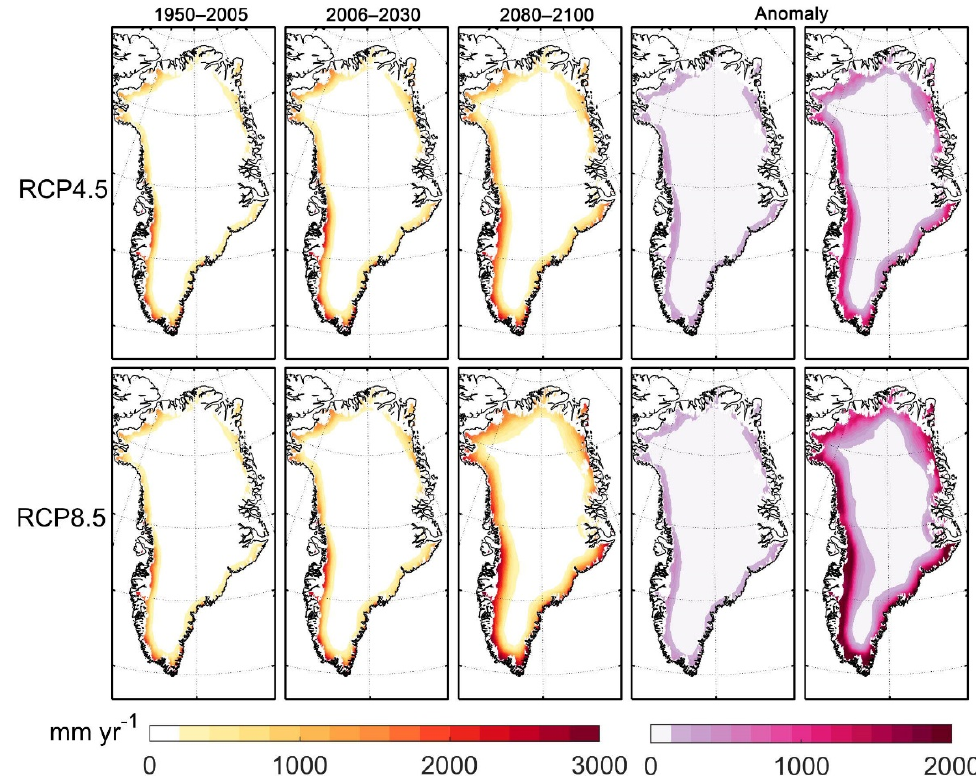
Figure 7. Spatial distribution of annual mean GrIS runoff during 1950–2005 (1st column), 2006–2030 (2nd column), and 2080–2100 (3rd column) estimated by SEMIC as the mean of eight albedo parameterizations under RCP4.5 (top row) and RCP8.5 (bottom row), and anomalies relative to 1950–2005 for 2006–2030 (4th column) and 2080–2100 (last column).